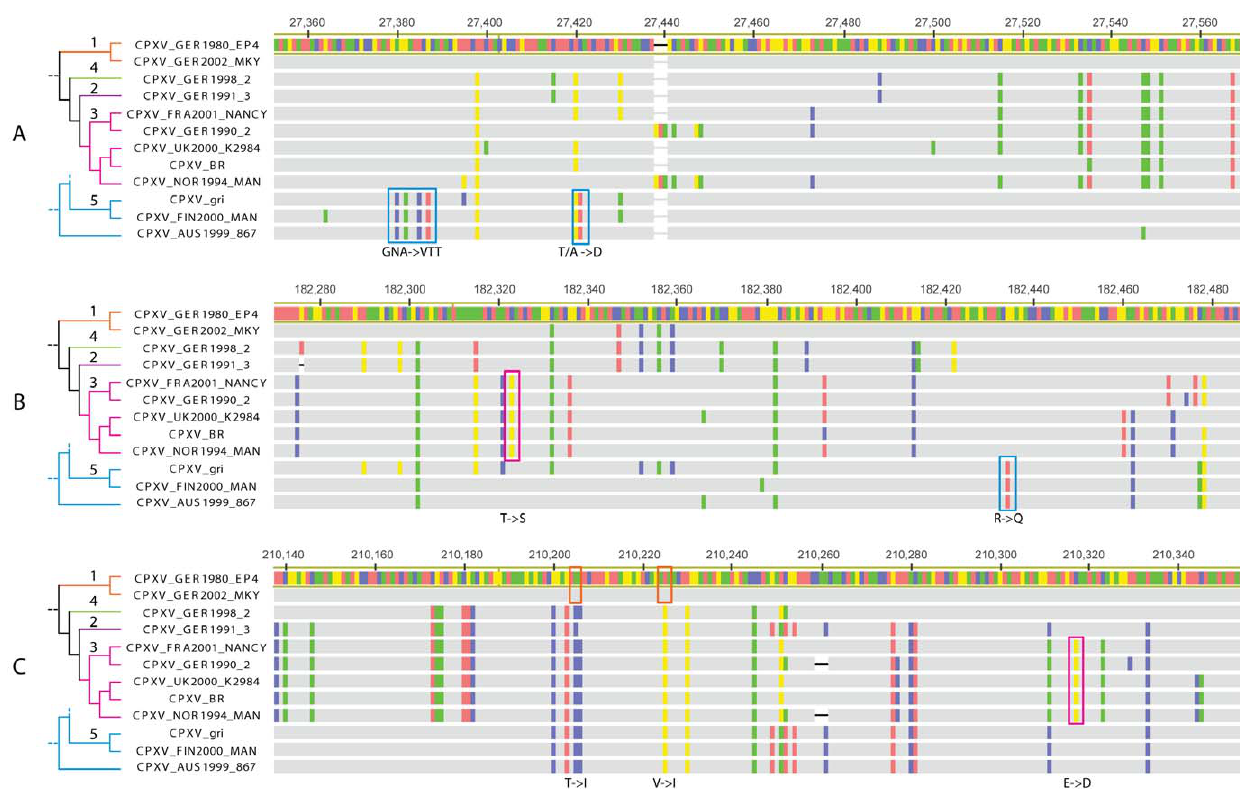
Figure 3. Alignment of three CPXV genes. Alignment images were created in Geneious Pro TM 5.3. Isolate names are provided to the right along with the branching relationships and numbered groups presented in Figure 1. Sequence areas depicted were extracted from the following coding regions: (A) CPXV_BR_021 (VACV_COP_C11R), secreted virulence factor, vaccinia growth factor (VGF; epidermal growth factor-like protein), promotes cell survival; (B) CPXV_BR_191 (VACV_COP_A53R), CrmC, viroceptor, soluble virus tumor necrosis factor receptor homolog, binds and antagonizes TNF- a ; (C) CPXV_BR_212 (VACV_COP_B19R), viroceptor, soluble IFN a / b receptor homolog, binds and antagonizes IFN a / b . Numbers along the top of the alignment refer to the position of the region in the full genome alignment (supplementary material). Grey indicates conserved bases while colors (red, blue, yellow, green) indicate differences (A, C, G, T, respectively) with regard to the reference sequence (CPXV_GER1980_EP4) highlighted in yellow. Colored boxes identify shared nucleotide states that reflect monophyletic relationships seen in the tree. Notations below each alignment describe subsequent amino acid changes (standard IUPAC code).